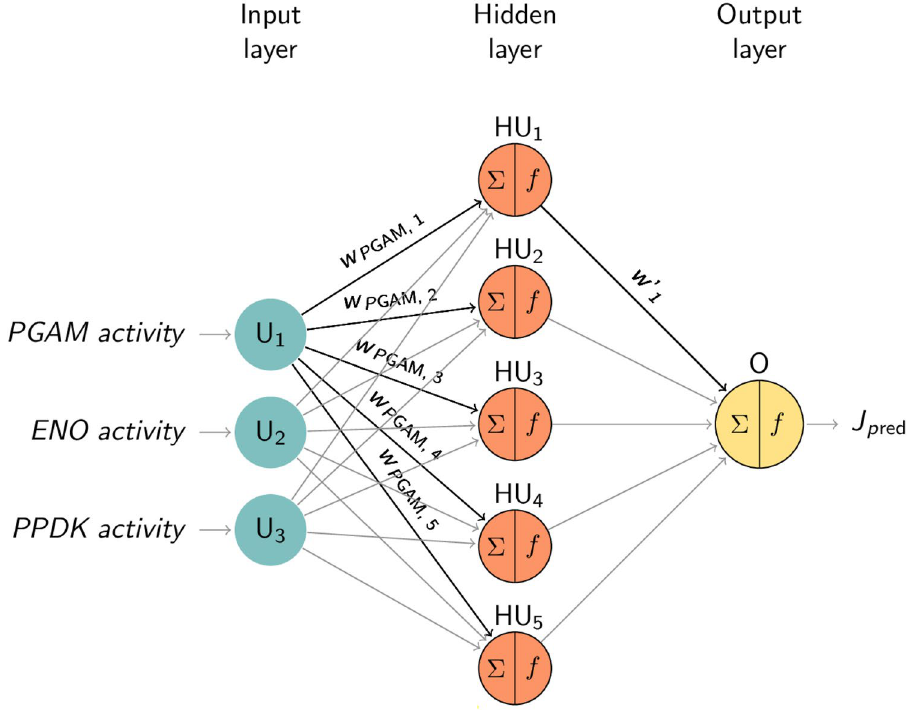
Figure 3. Structure of the ANN models. Each node represents an artificial neuron or unit. U i , HU j and O are, respectively, the input unit, the hidden unit and the output unit of the different layers; w i and w’ j are the weights associated with each connection of the network between the input and the hidden layer for the first, and between the hidden and the output layer for the second. Only weights for the first unit (associated with PGAM) of the layers are labelled. ∑ constitutes the weighted sum of the input and f constitutes the activation function applied in the unit.